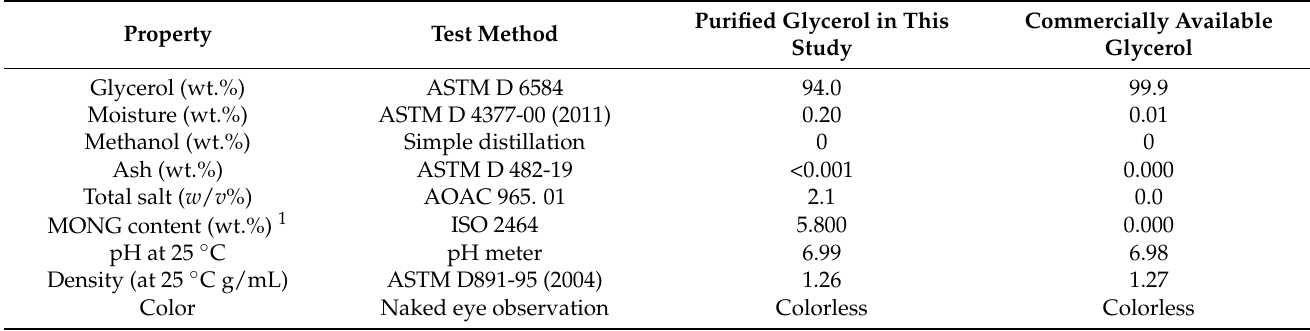
Table 3. Properties of purified glycerol and commercially available glycerol.